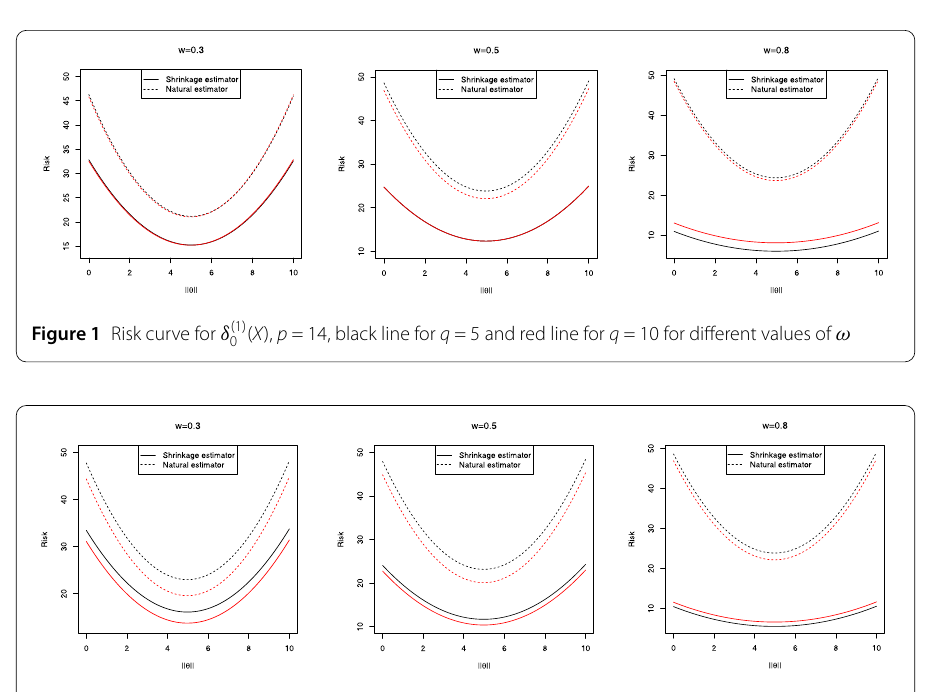
Figure 2 Risk curve for δ (2) 0 ( X ), p = 14, black line for q = 5 and red line for q = 10 for different values of ω